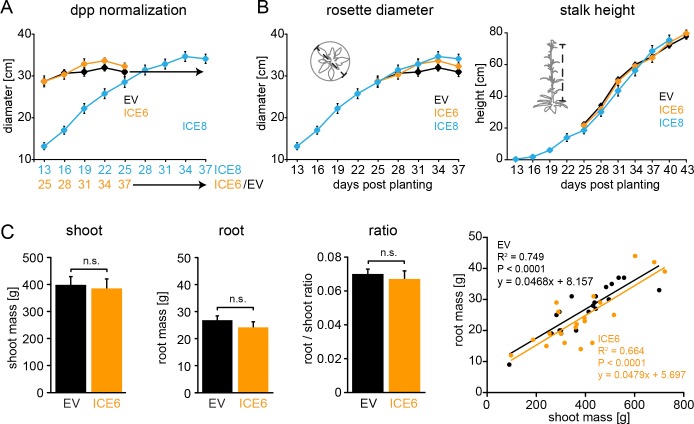
Growth performance of transgenic N. attenuata ICE 6 and ICE 8 lines did not differ from the controls in the field. Growth performances of N. attenuata ICE-lines were compared with empty vector controls (EV) in a field experiment at the Lytle ranch preserve Utah (USA). (A) Due to a mishap in germination the ICE 8 plants had been planted with a delay of 12 d compared to the controls and all growth parameters were normalized against days post planting (dpp), as illustrated with the rosette diameter. (B) Normalized rosette diameter and stalk heights of the transgenic plants showed no difference to the controls (±SEM, n = 20 plants). (C) The plant shoot and root fresh biomass was determined 43 dpp and did not differ in the ICE 6 plants compared to the controls (±SEM, n = 20 plants) (Mann-Whitney U test p>0.3, n.s. = not significant).